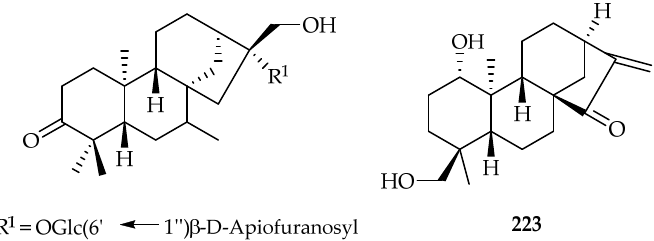
Figure 87. Structures of diosmarioside D 222 [136] and scopariusol L 223 [137].